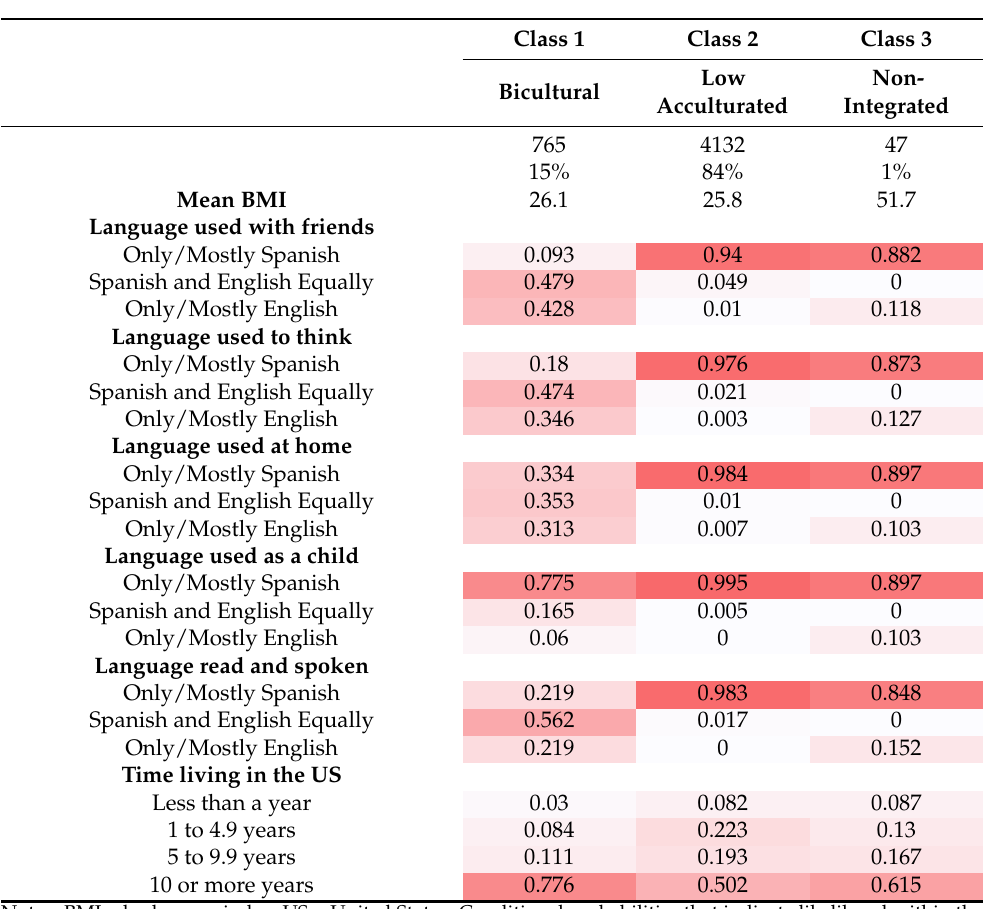
Table 2. Three-class solution conditional probabilities and mean (N = 4944).